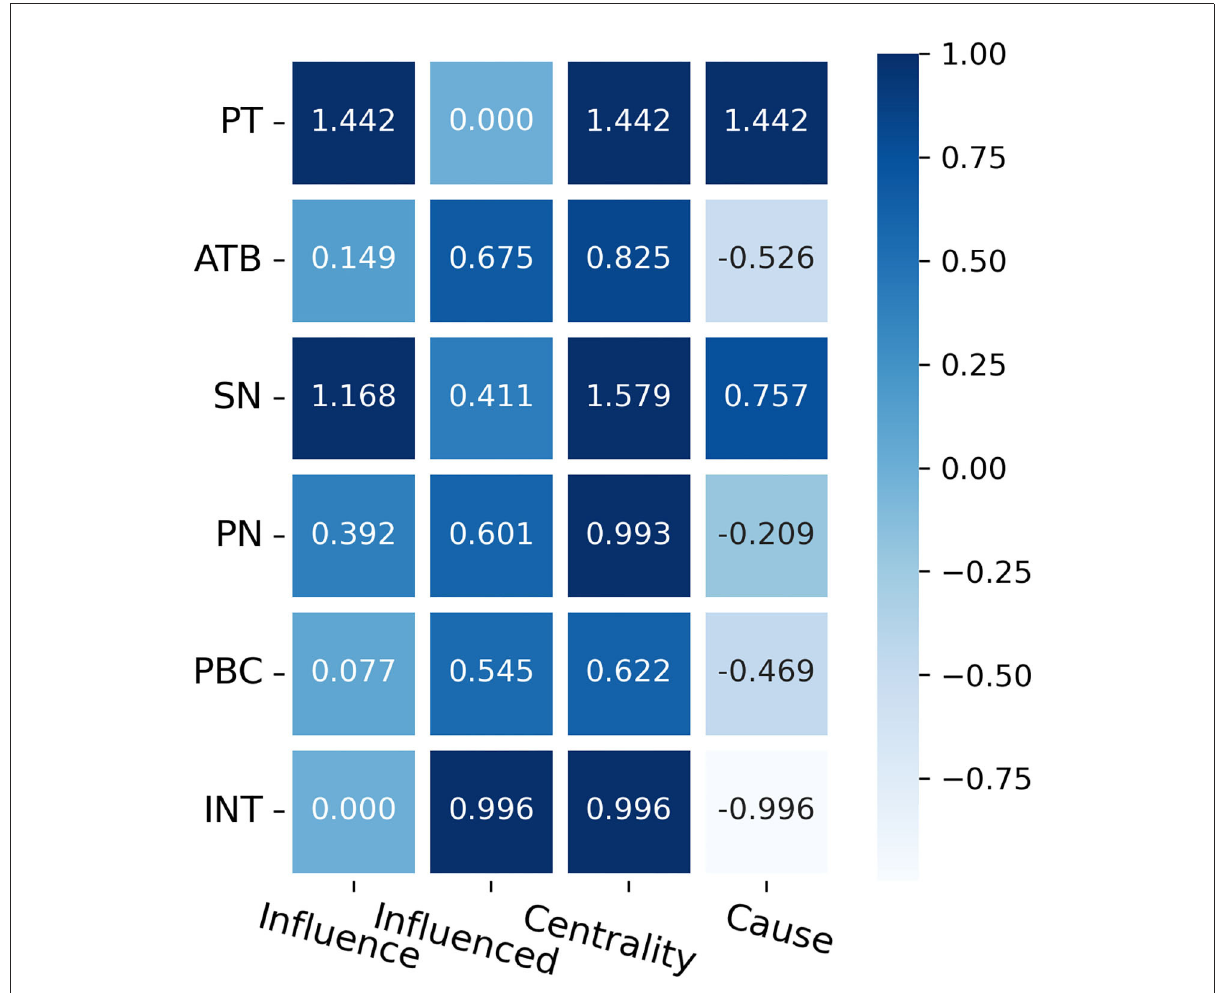
FIGURE5 Influence degree, influenced degree, centrality, and cause